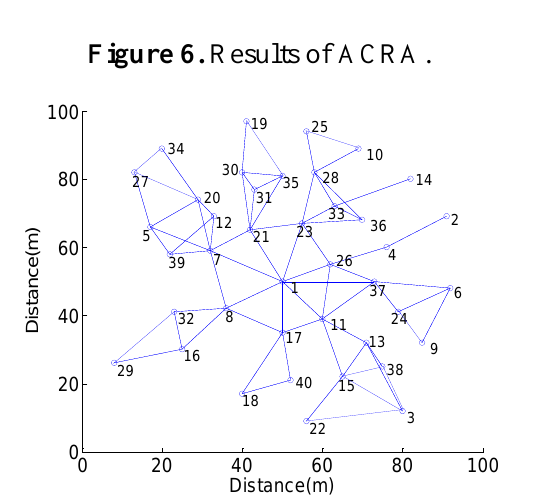
Figure 6. Results of ACRA.